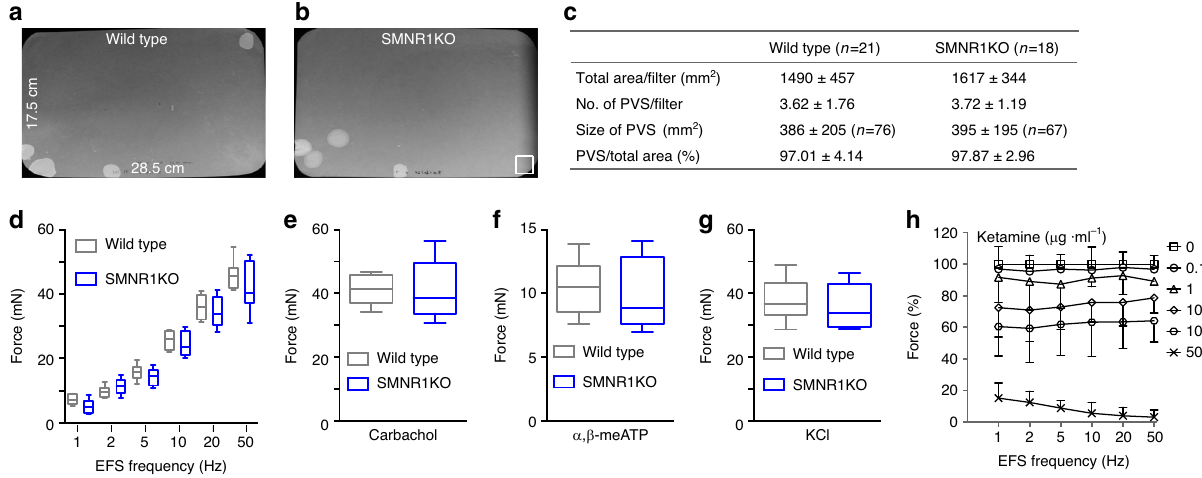
Fig. 2 Ketamine inhibition of BSM contraction is not mediated by NMDAR. Representative fi lters show UV light-illuminated urine spots from a wild type mouse ( a n = 21 fi lters) and a smooth muscle-speci fi c NR1 knockout (SMNR1KO) mouse ( b n = 18 fi lters). Summarized quantitative data ( c ) indicate normal voiding volume, normal spot number per void, and normal spot size for SMNR1KO mice. ± in c is SD of the mean. In b 400 mm 2 white box at bottom right serves as area standard. d – g BSM contraction in SMNR1KO mice stimulated by EFS ( d wild type n = 8 BSM strips, SMNR1KO n = 8 BSM strips), by 10 µ M carbachol ( e wild type n = 8 BSM strips, SMNR1KO n = 8 BSM strips), by 10 µ M α , β -meATP ( f wild type n = 8 BSM strips, SMNR1KO n = 8 BSM strips), or by 50 mM KCl ( g wild type n = 8 BSM strips, SMNR1KO n = 8 BSM strips). Data are shown as box and whiskers, center line is the median of the data set, box represents 75% of the data, and bars indicates whiskers from minimum to maximum. Data were analysed by Student ’ s t -test. h ketamine concentration-dependent inhibition of contraction of BSM from SMNR1KO mice ( n = 12 BSM strips). The data indicate that NMDAR does not mediate ketamine-induced inhibition of BSM contraction. Data are presented as mean values ± SD. Source data are provided as a Source Data fi